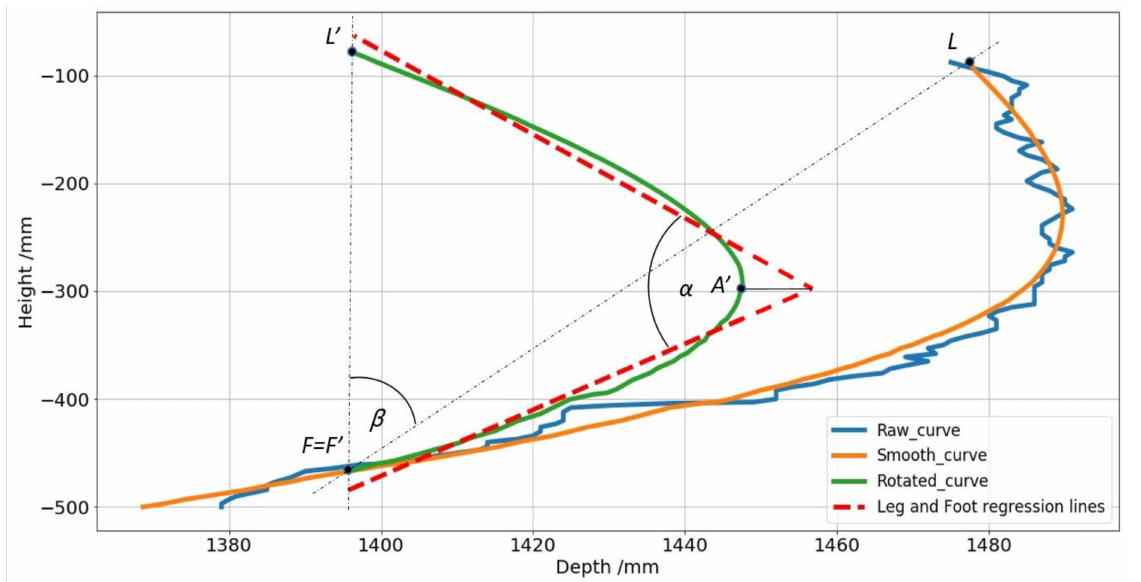
Figure 13. Graphic example showing the steps since the data obtained directly by the projection line (blue), the smoothed curve (orange) to the rotation line (green), that rotes beta degrees with the origin in the foot point, F, to keep the ankle as the furthest point to facilitate its recognition, A’. Finally, the regression lines (red) form the alpha angle, which is the angle of the ankle that is finally measured.